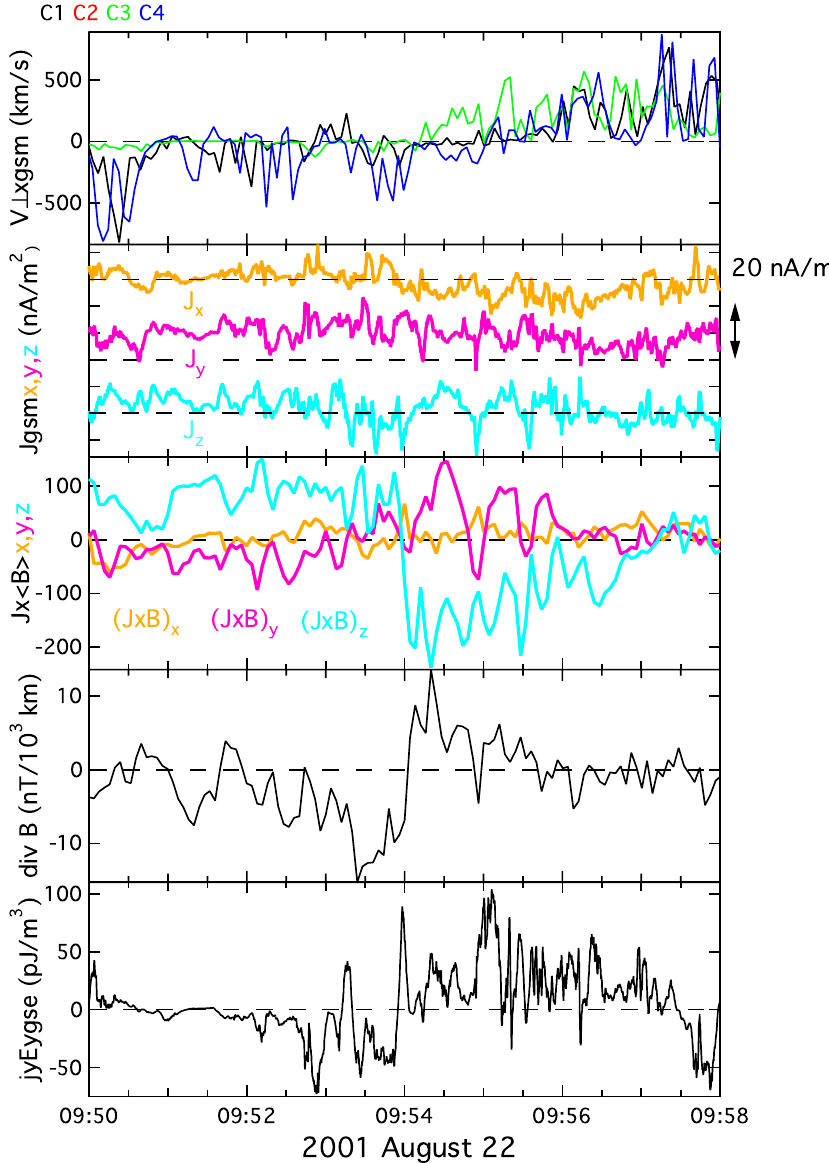
Fig. 6. Plasma parameters associated with current density during the plasma flow reversal. The unit for j × B components is nT-nA/m 2 .